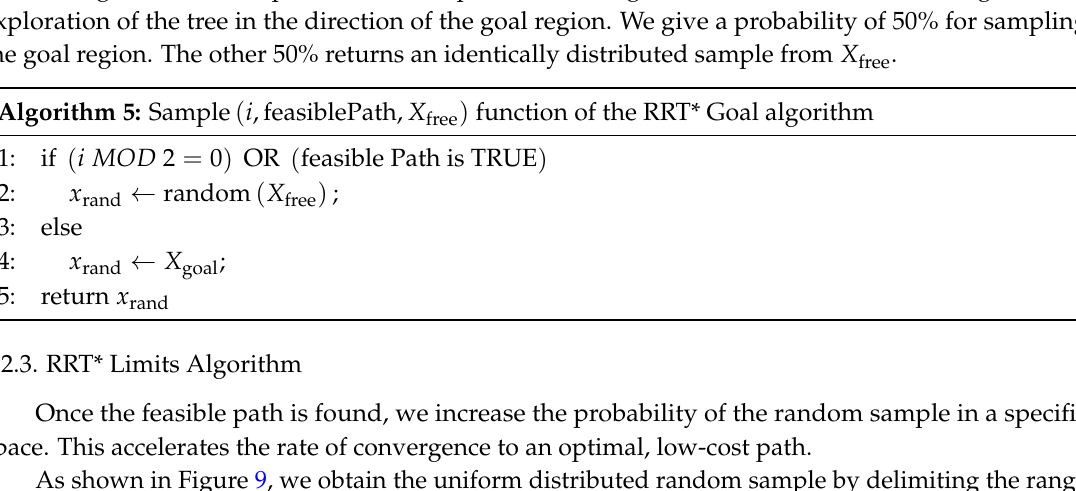
Figure 8. In gray the current tree vertices, in yellow the new vertex. ( a ) RRT standard resulting path; ( b ) RRT* optimal resulting